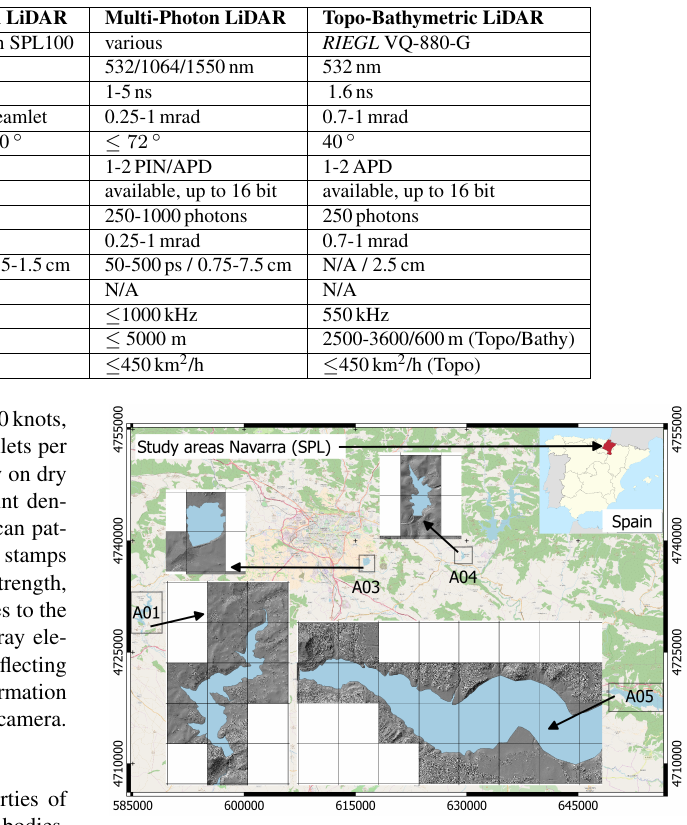
Figure 1. Single Photon LiDAR area Navarra; City of Pamplona area (OpenStreetMap) with selected reservoirs (A01, A03-05; gray boxes), coordinate frame: WGS84/UTM 30N; Details: terrain relief map of reservoir areas, coordinate grids: 1km.